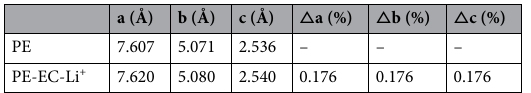
Table 4. Difference in the lattice constant of PE.